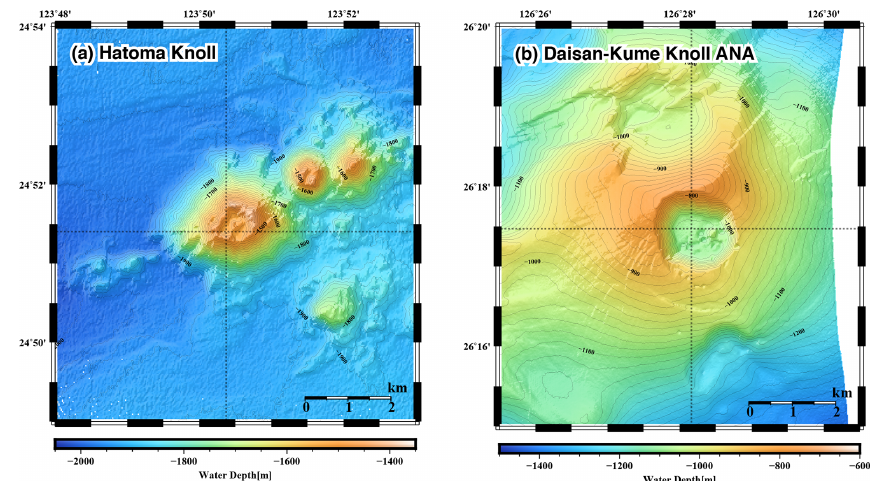
Figure 1. Seafloor topography of the (a) Hatoma Knoll site and (b) ANA site. Sampling locations are indicated as cross points of dotted